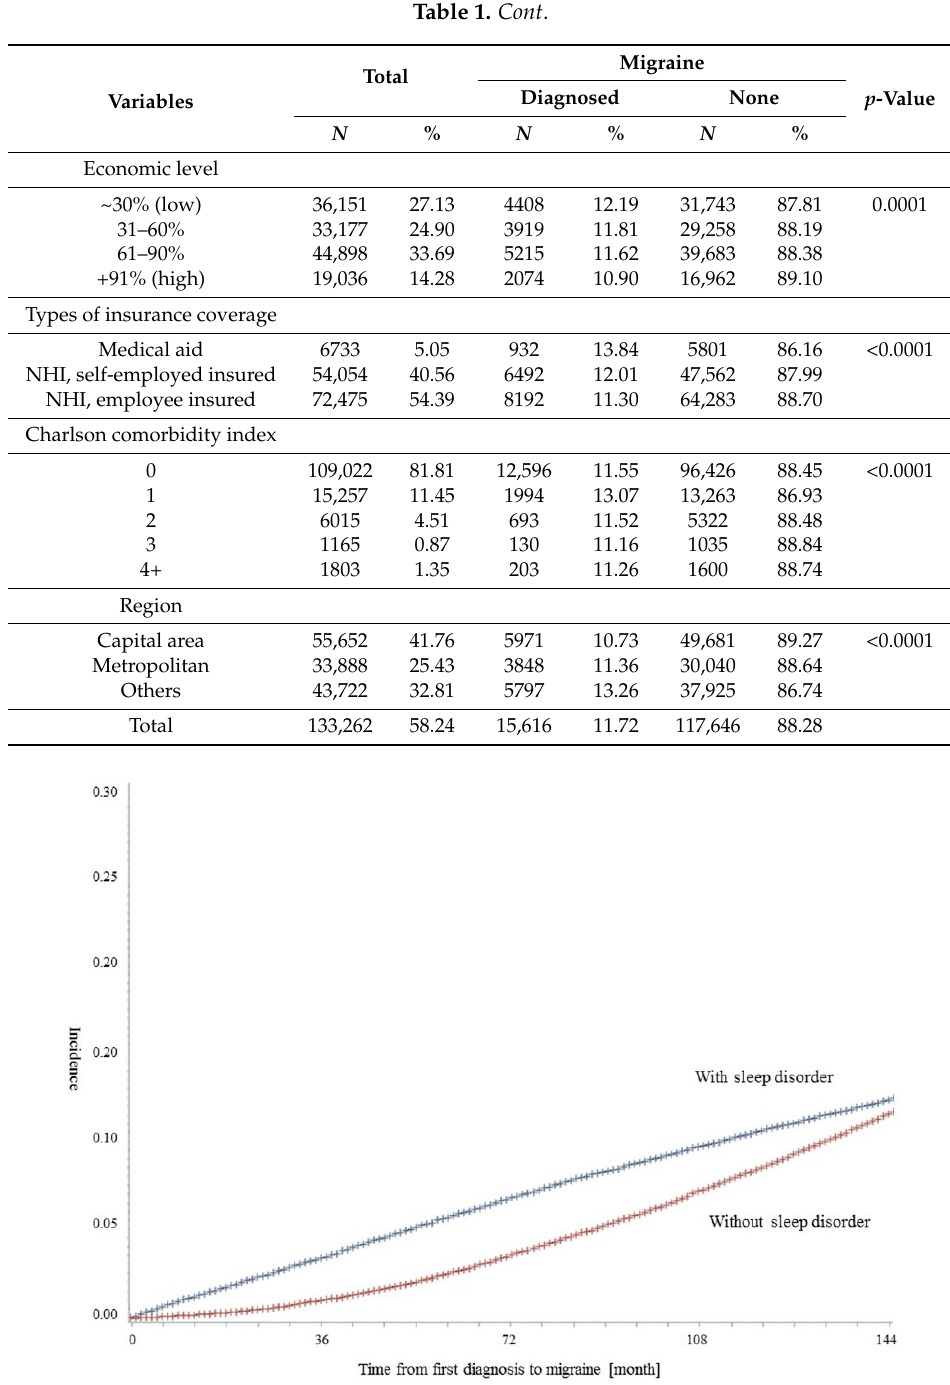
Figure 1. Kaplan–Meier survival curve for the incidence of migraine. The results of the log-rank test for time to migraine by the diagnosis of sleep disorder were statistically for time to migraine by the diagnosis of sleep disorder were statistically significant.